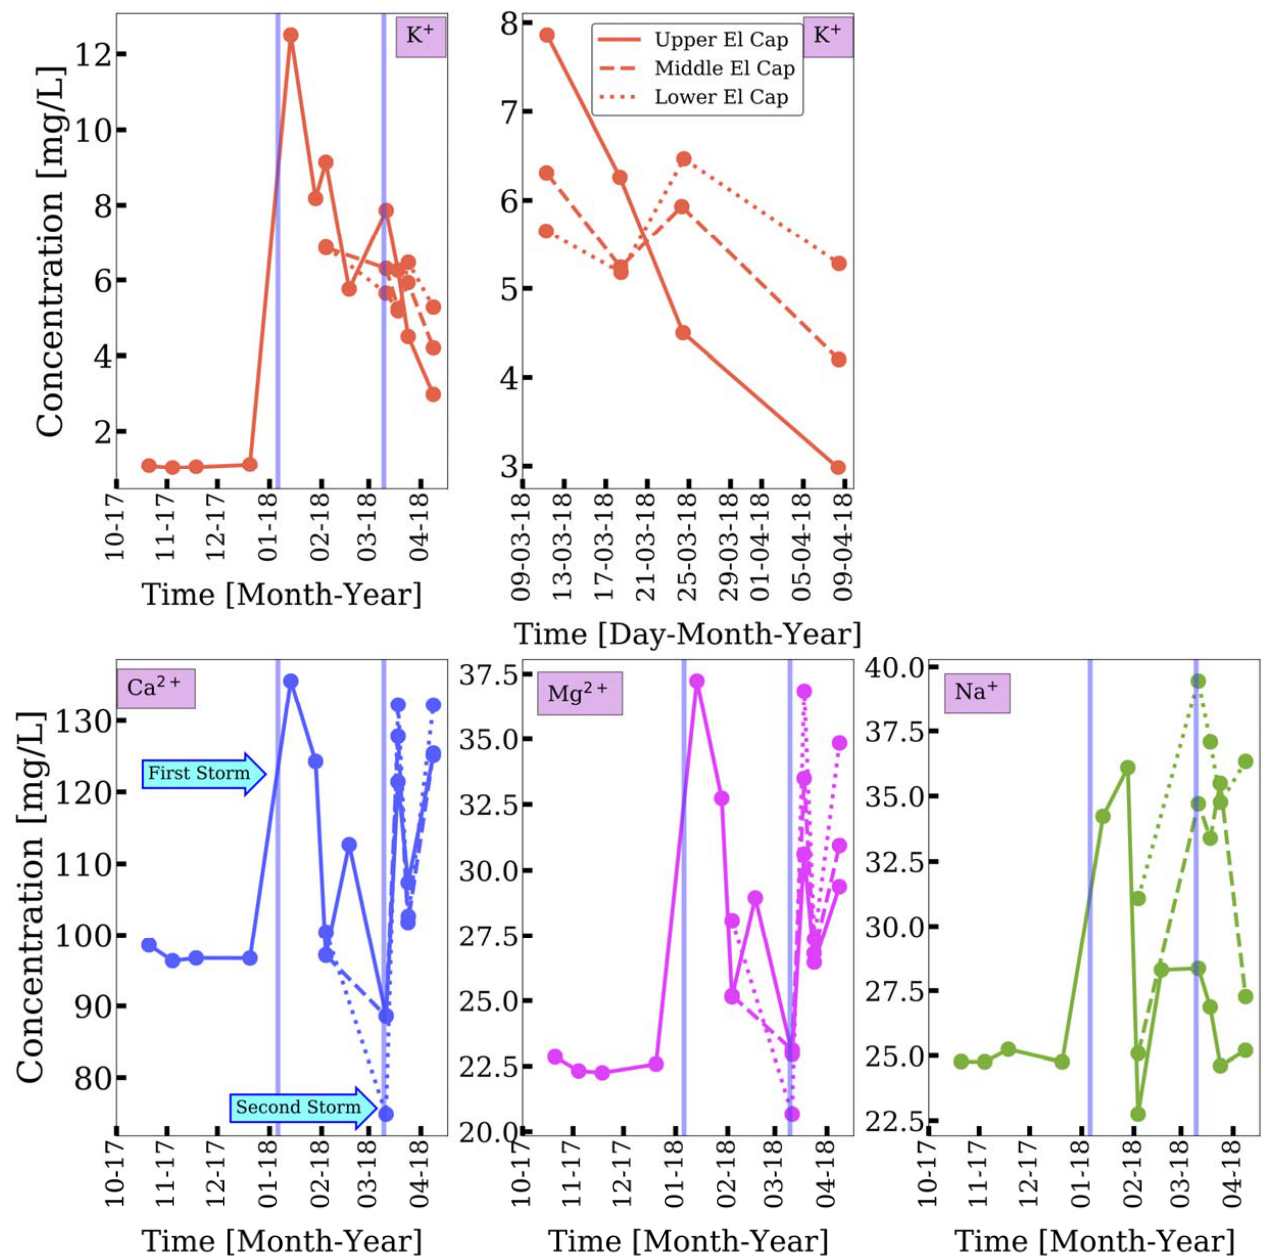
Figure 5. Concentrations of major cations in El Capitan Creek by sampling site: Upper El Cap (solid line), Middle El Cap (dashed line), and Lower El Cap (dotted line). The data from Figure 3 recorded for site Upper El Cap begins prior to the first storm (6 January 2018) and is included here. Data collection began at the Middle and Lower El Cap sites on 3 February 2018 and continued on a weekly basis following the second major storm of the season from 11 March 2018 to 8 April 2018. The top right panel magnifies the last four K + measurements at the Upper, Middle, and Lower El Cap sites (top left panel) for